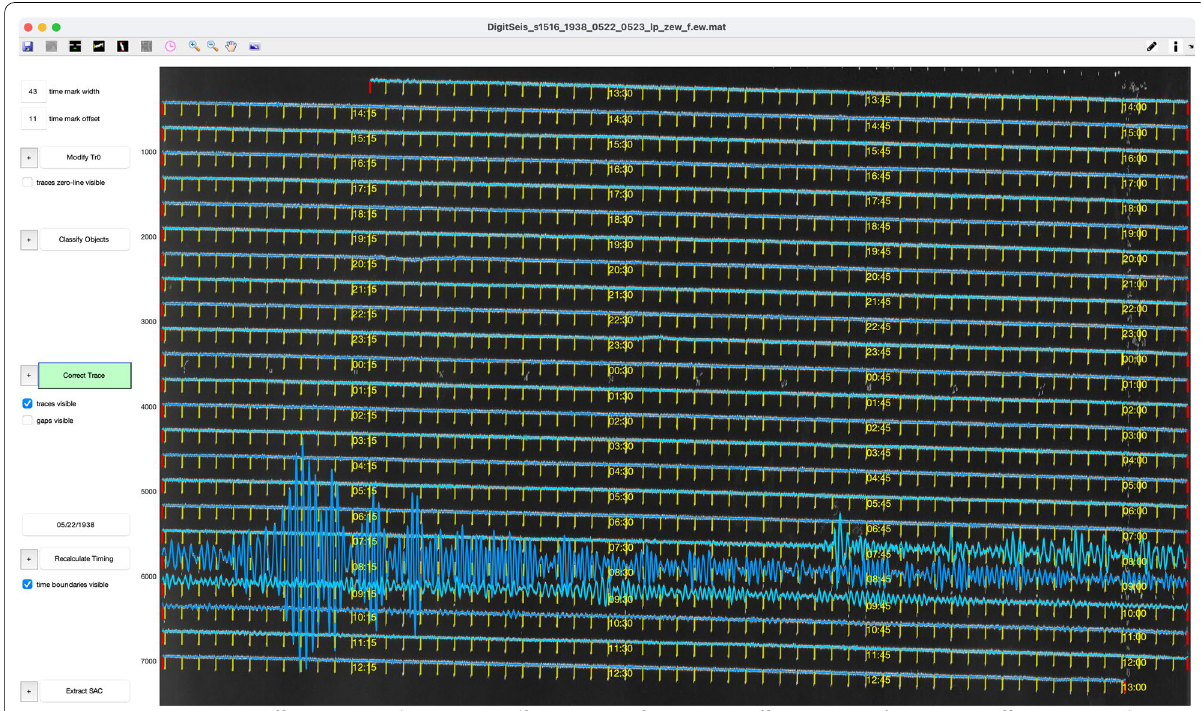
Fig. 4 Digitization Example 1: 1938 Earthquake Off Coast of Northern Ibaraki, Japan. Screenshot from DigitSeis showing the completed analysis of the May 22–23, 1938, long-period east–west seismogram recorded at the Harvard Seismographic Station. The left column contains various functionalities in the form of push-buttons and editable boxes which the user goes through from top to bottom to process the analogue seismogram digitization. Most of the screen space is taken up by the image window on the right where the digitized traces in light and dark blue are overlain on top of the analogue seismogram image. The yellow vertical bars indicate the rightmost location of each time mark, providing the position at which each minute begins, and the vertical red bars show the beginning and ending of each line. Time stamps (in UTC) are given for each 15-minute interval. Note that a beta-version of DigitSeis 1.6 is used here; hence, the layout of functionalities is not the same as the released version